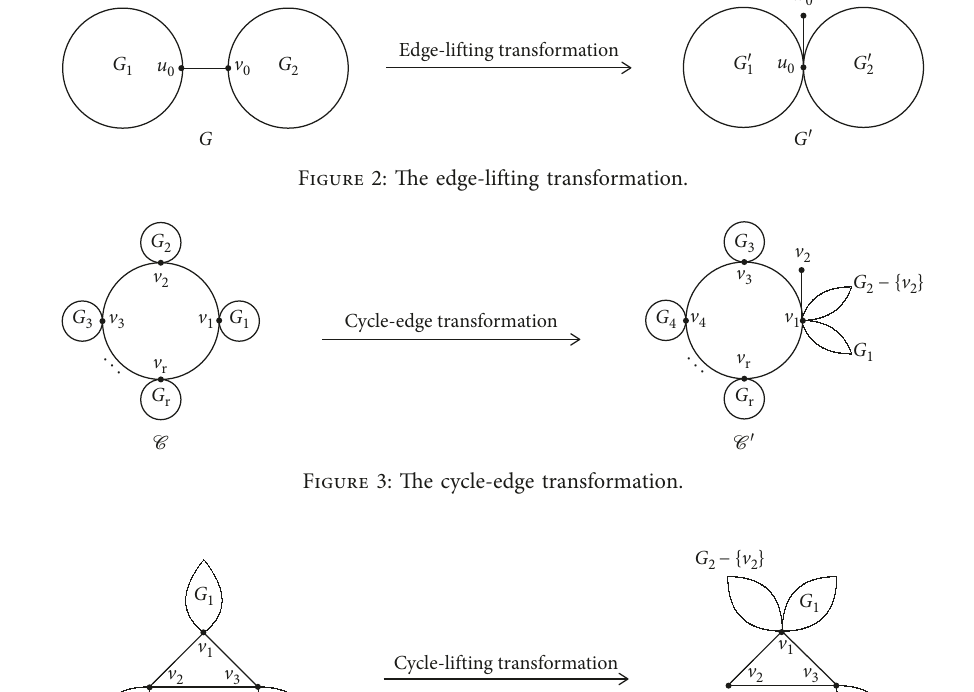
Figure 3: The cycle-edge transformation.